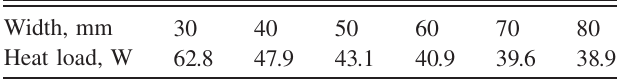
TABLE VIII. Heat load on the 25th beam pipe for different horizontal apertures (widths).